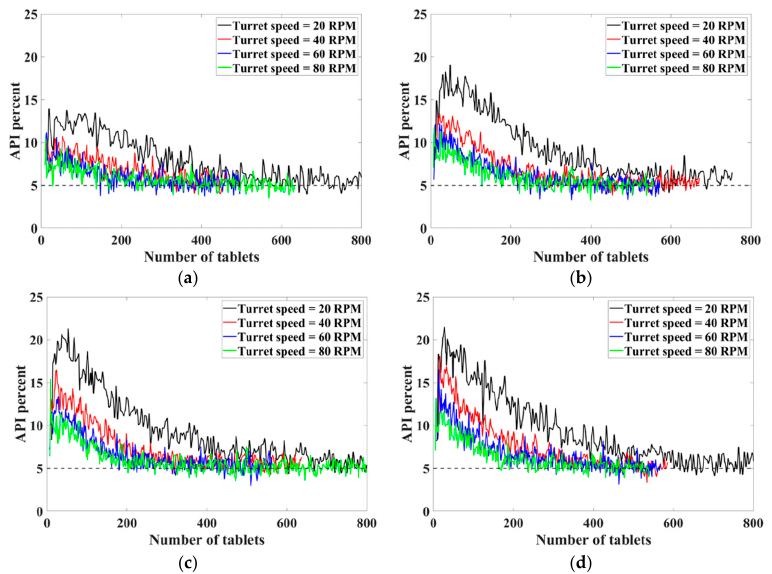
Figure 16. The change in API content during tablet manufacture using different paddle and turret speeds. An increase in turret speed and a decrease in paddle speed significantly increase the API content of the tablet. The API content eventually stabilizes at 5%. ( a ) Paddle speed = 20 RPM; ( b ) Paddle speed = 40 RPM; ( c ) Paddle speed = 60 RPM; ( d ) Paddle speed = 80 RPM.